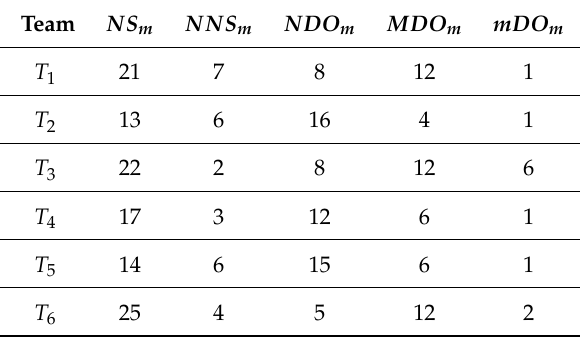
Table 8. Detailed analysis of the manual physician schedule for